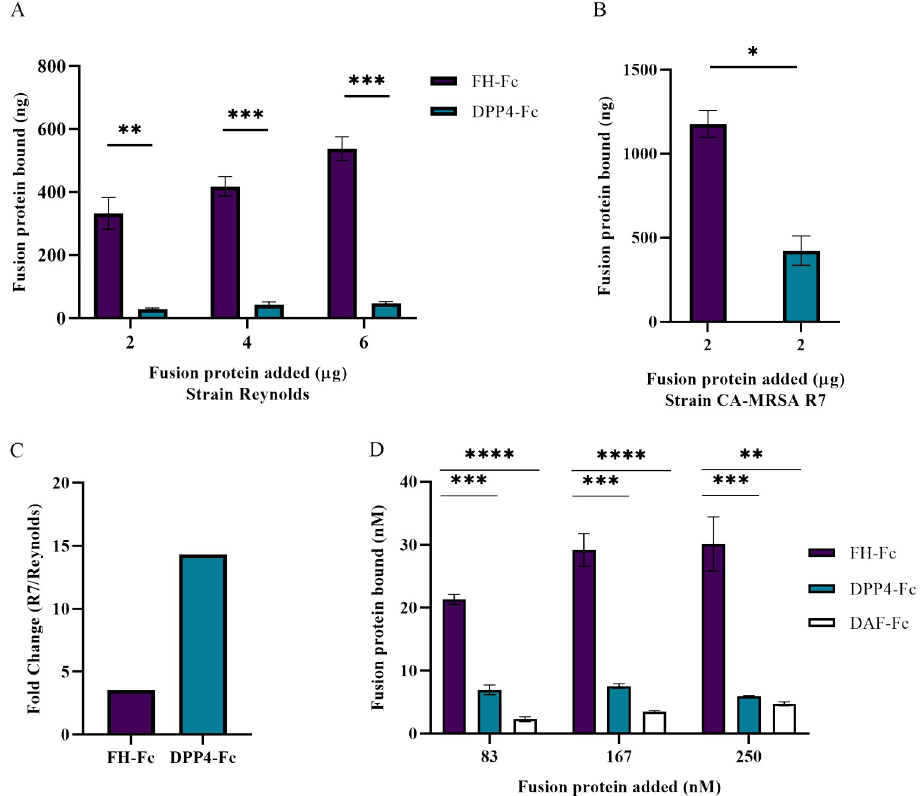
Fig 2. S . aureus binds significantly more FH-Fc than Fc-control protein. A, Fusion protein binding to lab strain Reynolds. B, Fusion proteins binding to CA-MRSA R7. C, Fold change of fusion protein binding to CA-MRSA R7 vs lab strain Reynolds (fusion protein added at 2 μ g). D, Fusion protein binding to CA-MRSA R7, nM comparison. Data represent the mean of at least three independent experiments ± SEM. � p < 0.05, �� p � 0.004, ��� p � 0.0003.